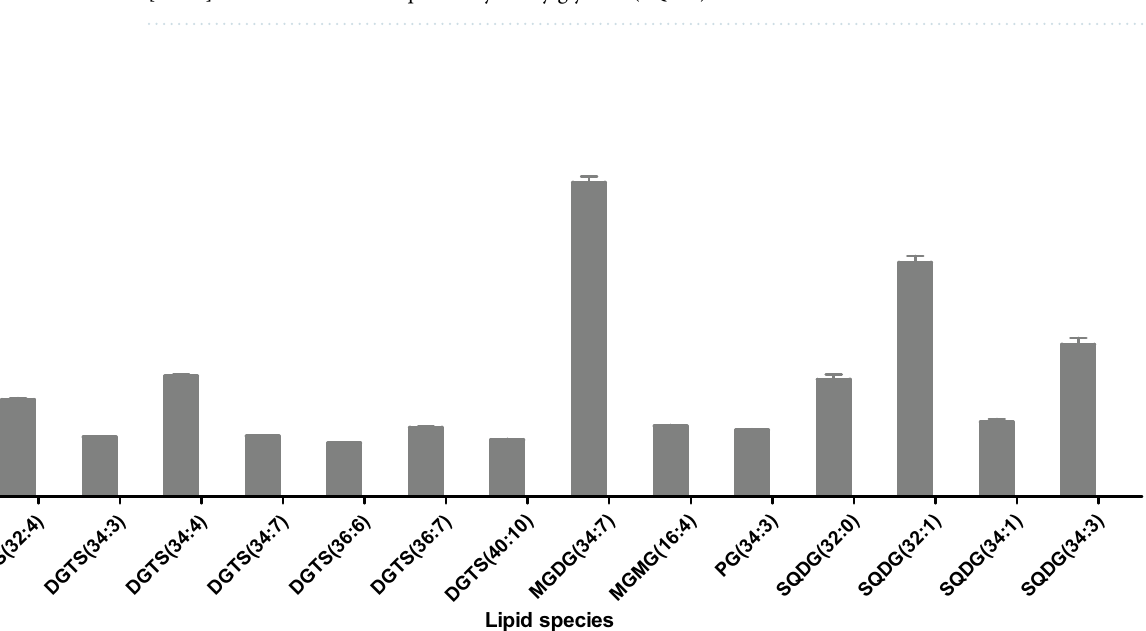
Figure 5. HILIC–HR–ESI–MS spectrum of the classes of glycolipids (GL) identified in negative ion mode as [M−H] − . This class was sulfoquinovosyl diacylglycerol (SQDG).